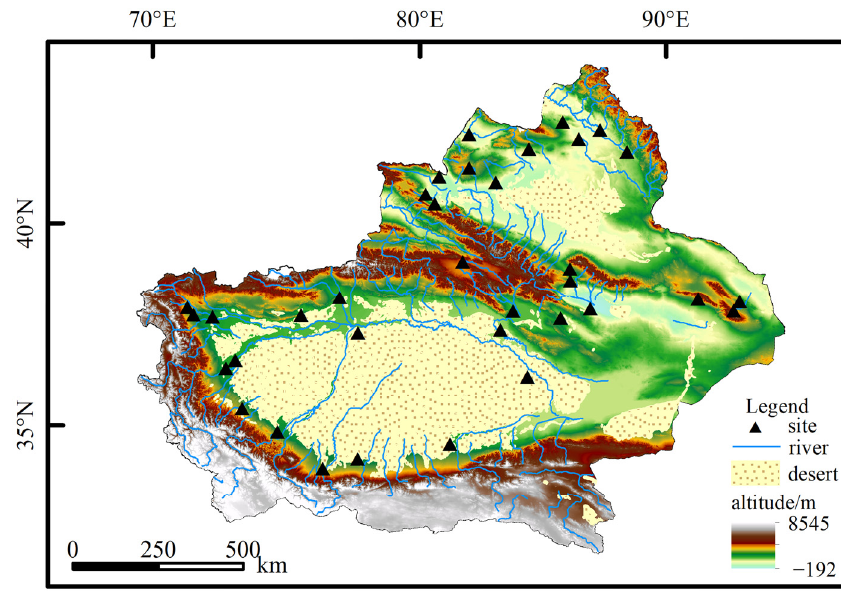
Figure 1. Geography and meteorological stations of